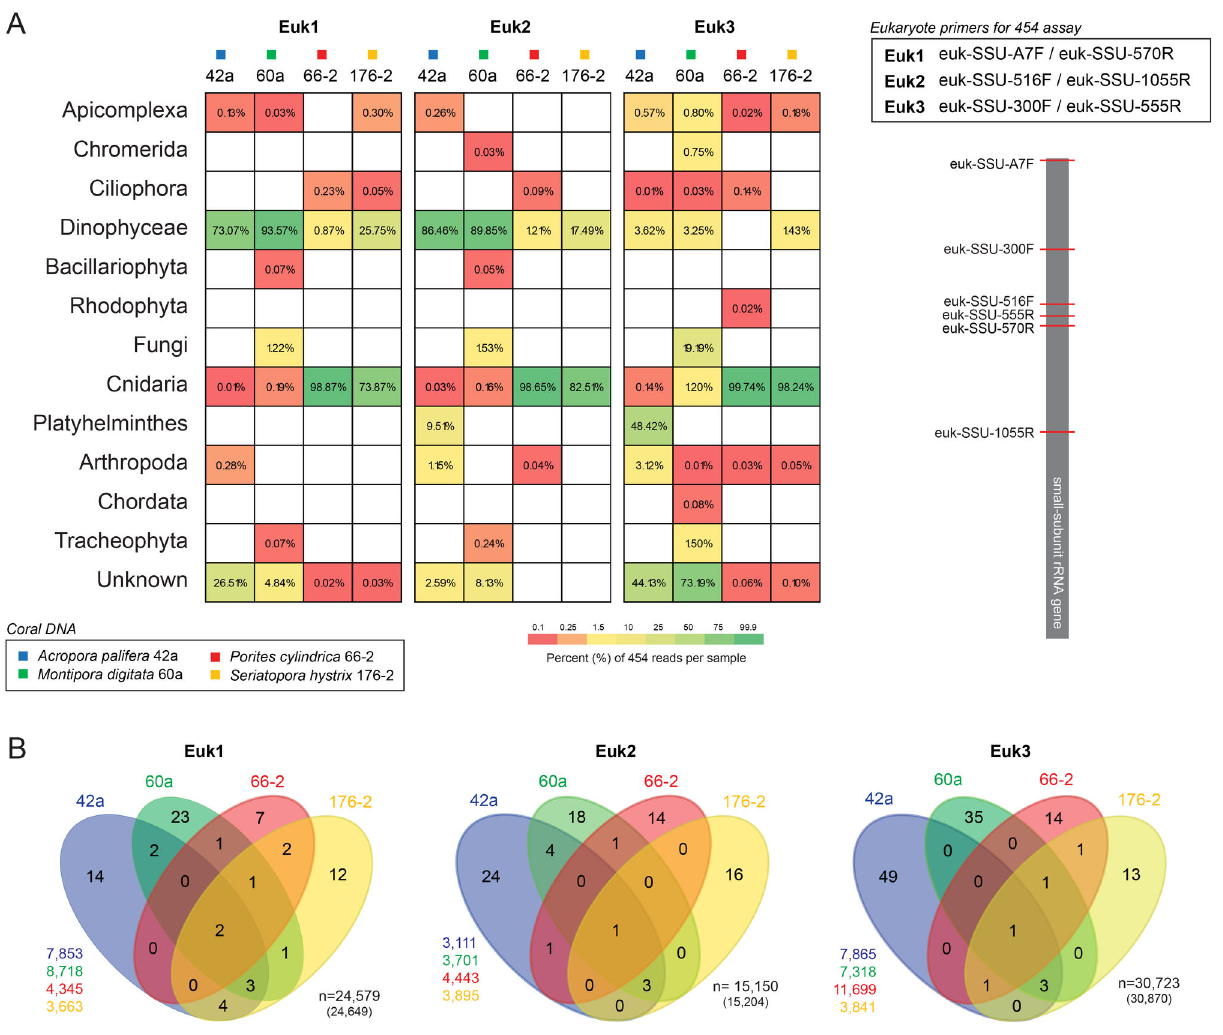
Figure 1. Comparative distribution of eukaryotic sequences in Great Barrier Reef coral holobionts. (A) Abundance of sequences belonging taxonomic groups of Eukaryotes in corals using three tag encoded 454 amplicon pyrosequencing assays targeting eukaryote small-subunit rRNA gene assays (Euk1, Euk2, Euk3). Relative position of the universal primer pairs utilised Euk1-3 assays is schematically shown on a complete small-subunit rRNA gene (inset right). (B) Venn diagram of sequence 97% sequence identity clusters shared between corals according to Euk1-3 assays. Number of sequences used to calculate Venn diagram within 97% clusters (>1 sequence) obtained using Euk1-3 assay and DNA indicated on the left (colour coded according to coral DNA). Total number of sequences recovered for each Euk1-3 (number in brackets on the right) and number sequences represented by >1 sequence (n). Coral species Acropora palifera 42a, Montipora digitata 60a, Porites cylindrica 66-2 from Heron Island and Seriatopora hystrix 176-2 from the One Tree